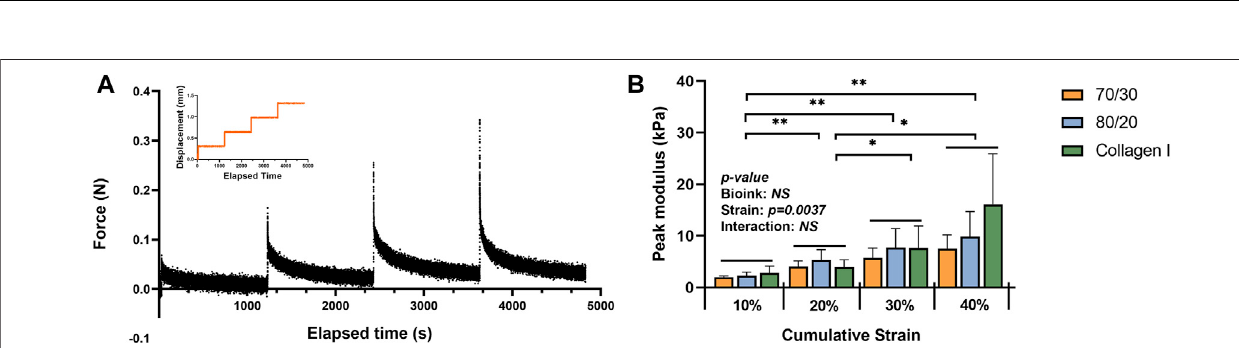
Frontiers in Bioengineering and Biotechnology |